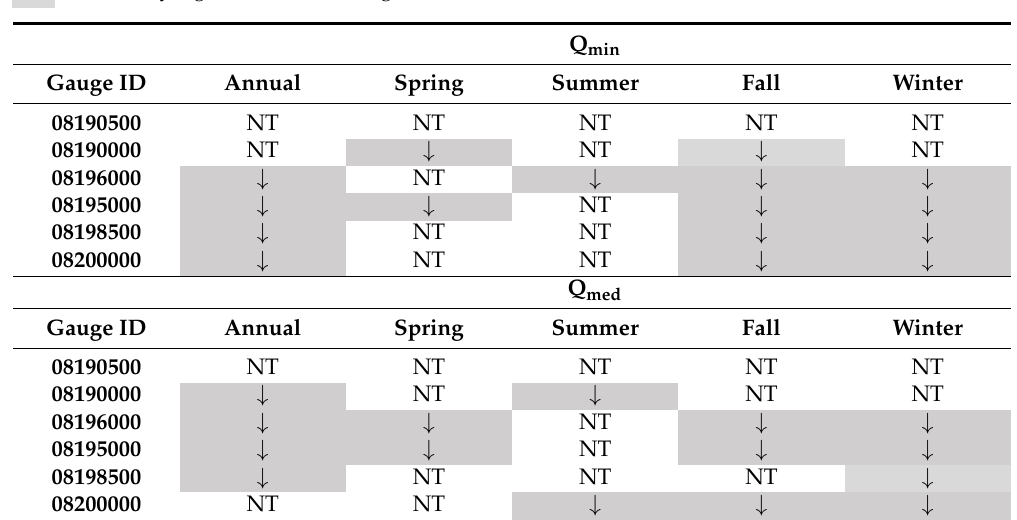
Table 3. Annual and seasonal NRB streamflow trends from 1970 to 2014 ([NT] no significant trend; [ ↓ ] statistically significant decreasing